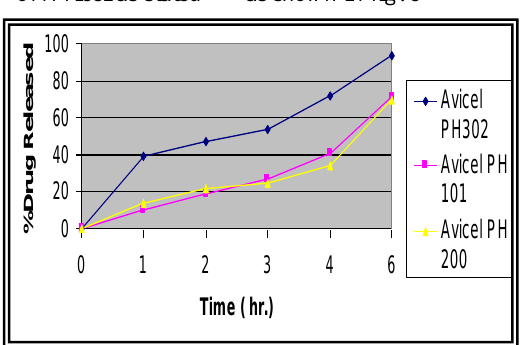
Figure 3 : Effect of Avicel grade on the percent released of nicotine at pH6.8 and 37 o C.